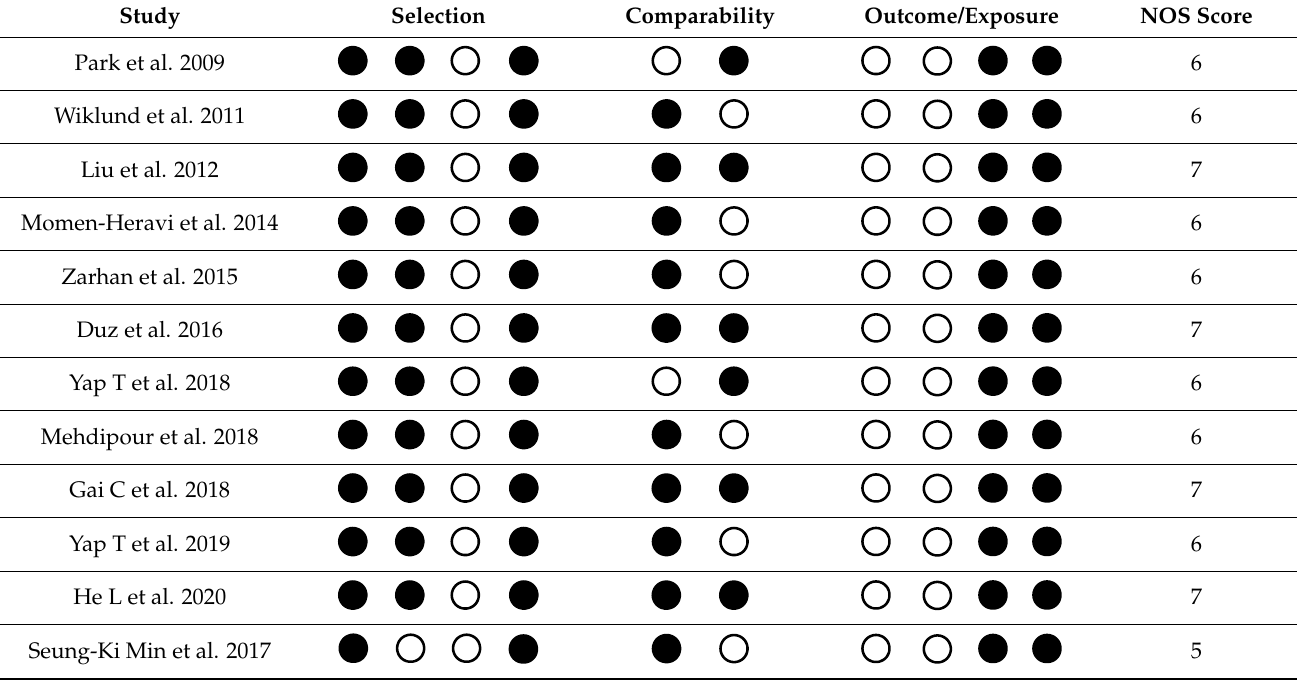
Table 2. Risk of bias of included studies.